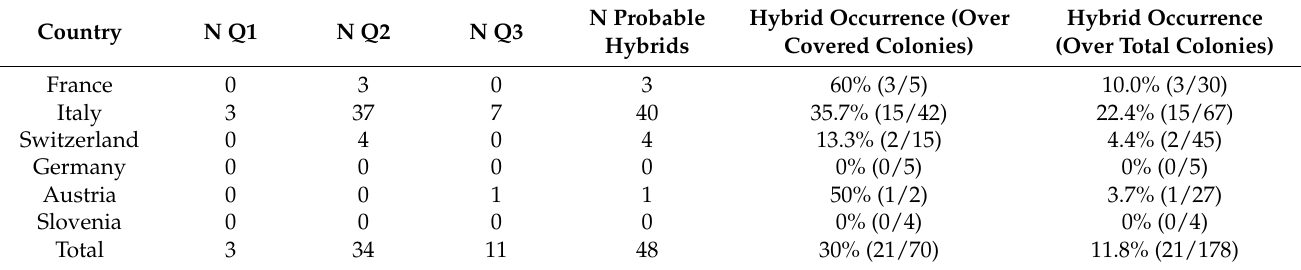
Table 2. Summary table of the number of Q1, Q2, and Q3 reports, of the total number of probable hybrids and of the estimated abundance and occurrence of probable hybrids at the country